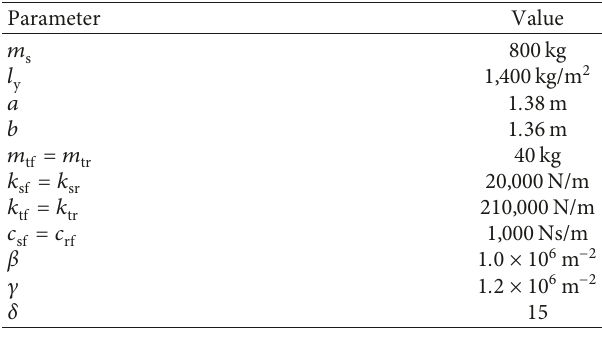
Table 1: One-half vehicle suspension parameters for simulation work.